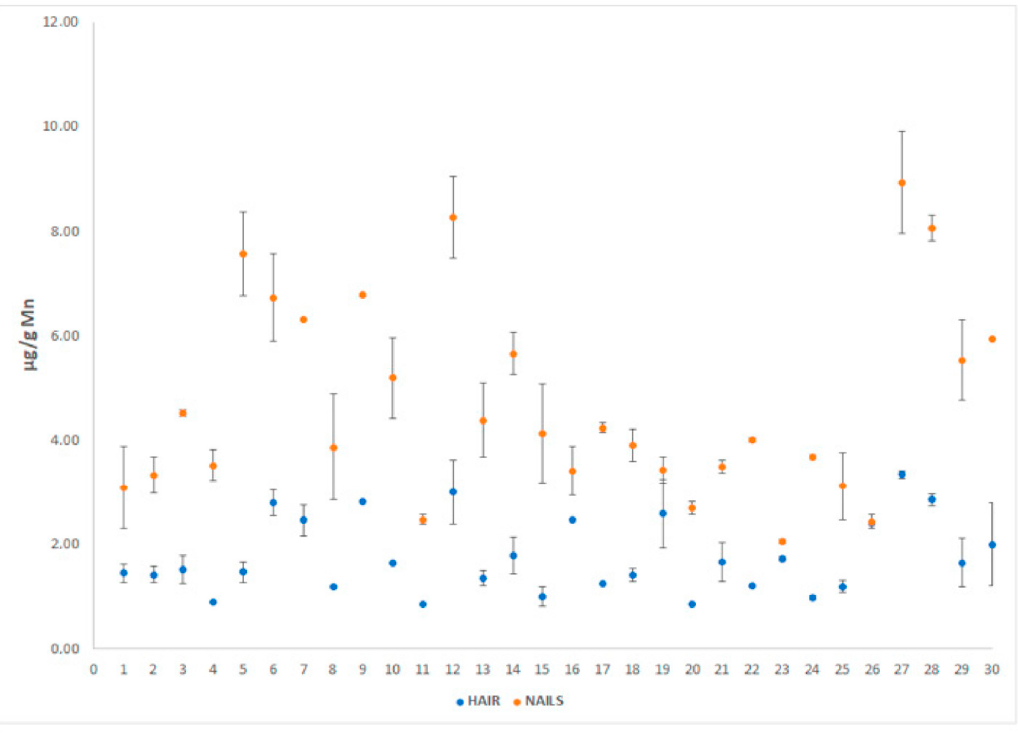
Figure 5. Mn concentration in human hair and nail samples.